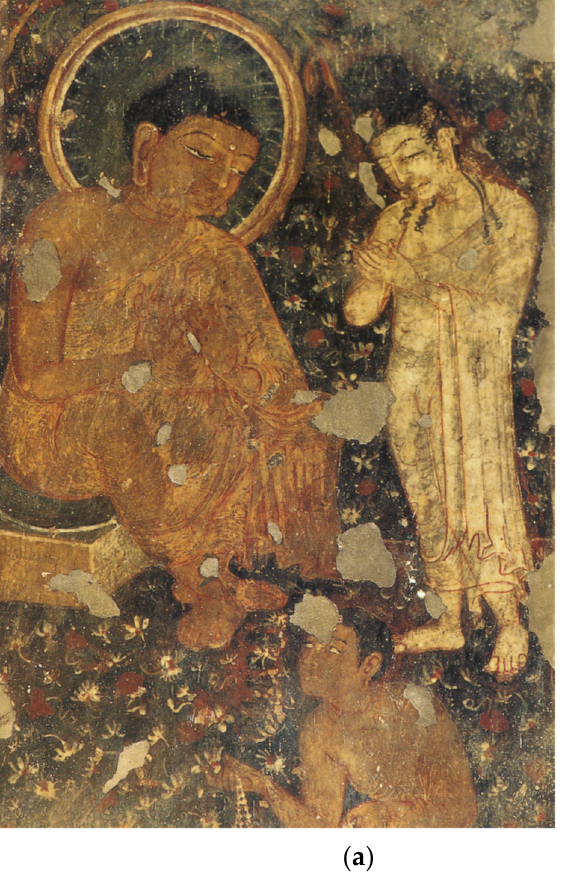
Figure 3. Intrusive mural painting on pillar L9 from Aja ṇṭ ā Cave 10, ca. 478–480 CE (( a ): Photograph after Behl 1998, p. 43; ( b ): Line drawing after Zin 2003, vol. 2, pl. 22c). Several rows of other Buddhas preaching and seated in bhadr ā sana are painted on top of the pillars; they are alternately dressed in white or red robes (Figure 4). 9 Because no